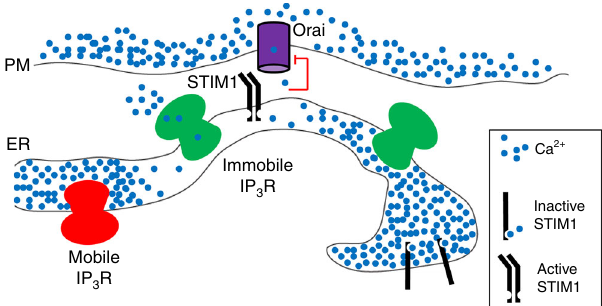
Fig. 9 Ca 2+ signals evoked by SOCE occur alongside immobile IP 3